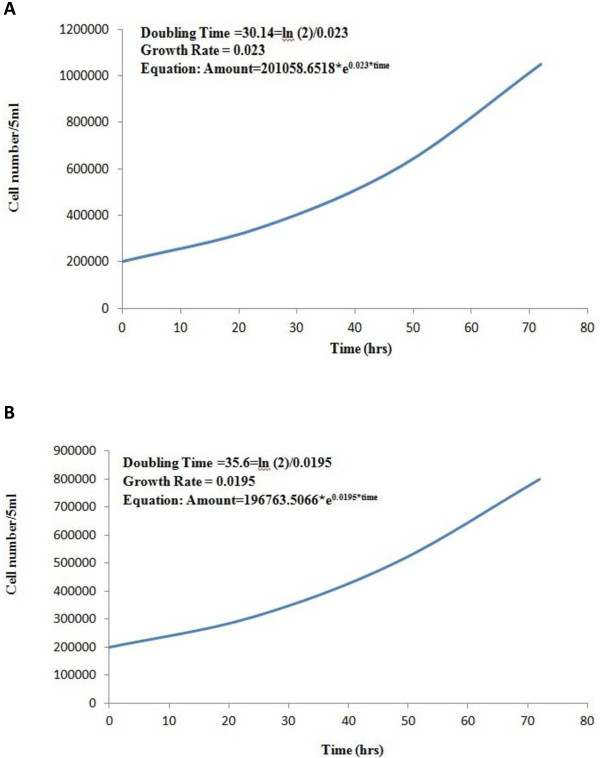
A: Population Doubling Time (PDT) of the MBC1 Cell Lines. Proliferation of the MBC1 was analysed by counting the total cell number at 0, 24, 48 and 72 time points. MBC1 proliferates in vitro with a PDT of 30.14 hours. B: Population Doubling Time (PDT) of the MBC2 Cell Lines. Proliferation of the MBC2 was analysed by counting the total cell number at 0, 24, 48 and 72 time points. MBC2 proliferates in vitro with a PDT of 35.6 hours.